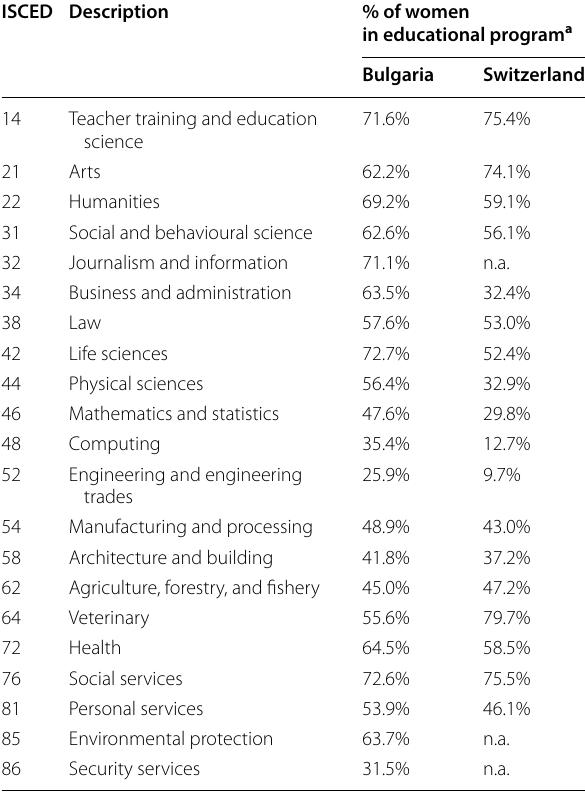
Table 11 Classification of educational programs (ISCED97 2-digits) and share of women per educational program